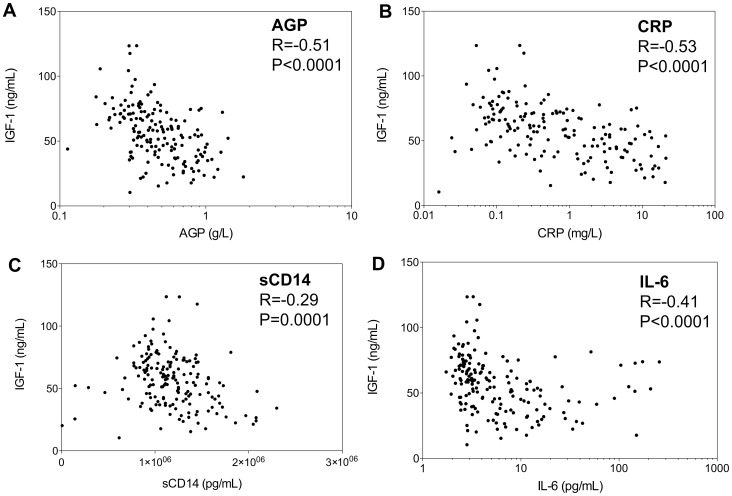
Relationships between pro-inflammatory markers and IGF-1.Associations between levels of IGF-1 and (Panel A) AGP, (Panel B) CRP, (Panel C) soluble CD14 and (Panel D) IL-6, at 3 months of age. Data for cases and controls are combined. Spearman correlations are shown.